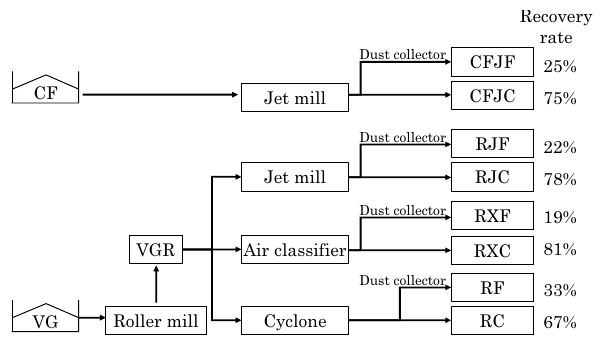
Fig. 7 Manufacturing process of VGP and clay